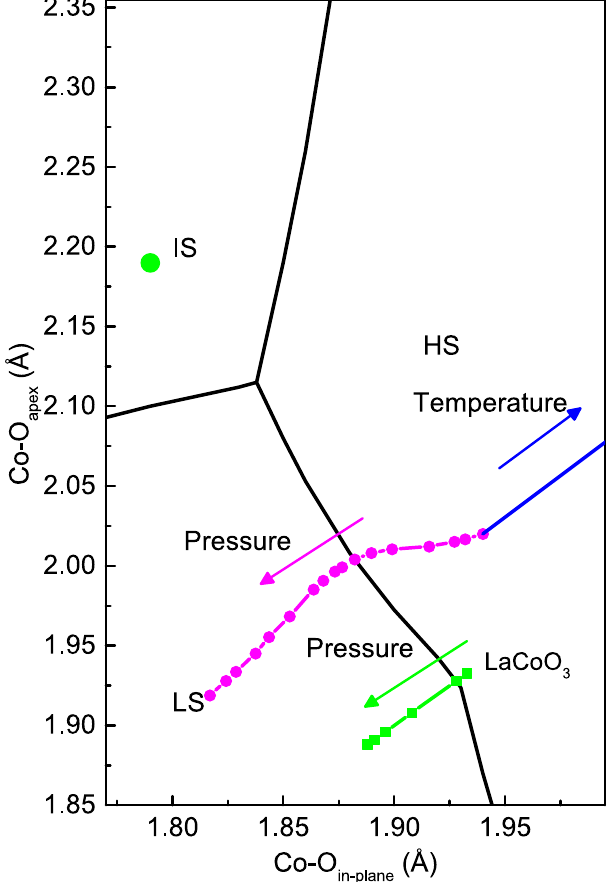
Figure 7. The phase diagram of the ground state of Co 3 + as a function of Co-O bond lengths. The magenta circles are the Co-O bond lengths of Sr 2 Co 0.5 Ir 0.5 O 4 estimated from ref. 28 and the blue line refers to an increase of its Co-O distance with temperature by keeping the ratio of Co-O apex /Co-O in-plane at room temperature. The green circle is those of one of two Co 3 + sites in the O-phase in TlSr 2 CoO 543 . The green line represents the Co-O distances of LaCoO 339 with